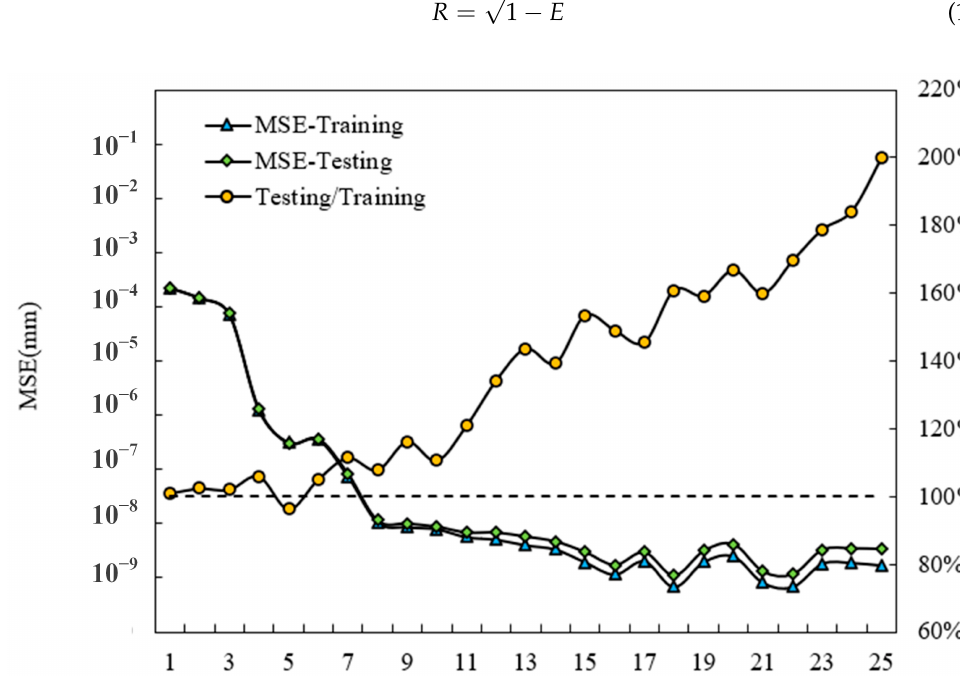
Figure 15. The network error and overfitting analysis. Table 8. Network